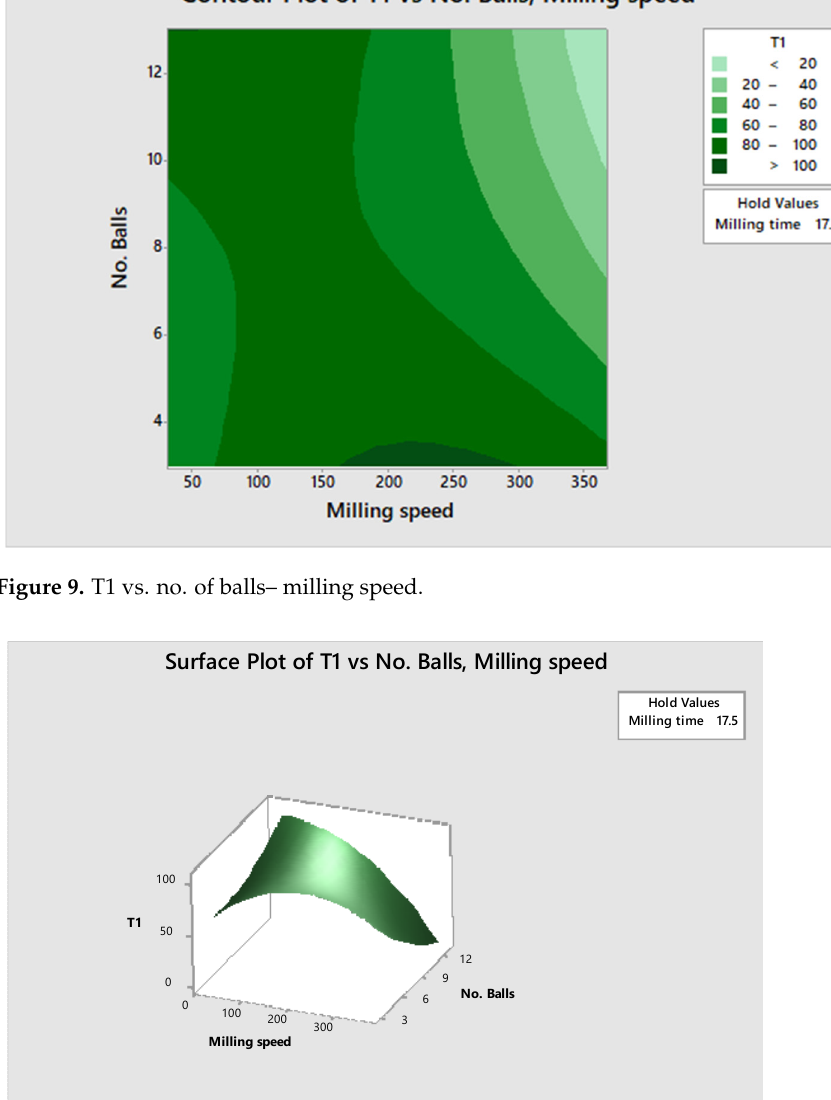
Figure 8. Mass fraction of fines size class against mass fraction of the intermediate size class for different speeds).